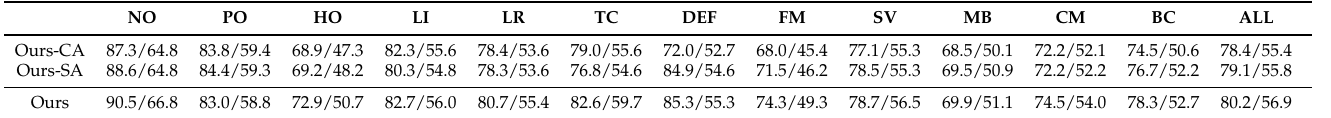
Table 2. Attribute-based PR/SR scores ( % ) on RGBT234 dataset in ablation experiment.